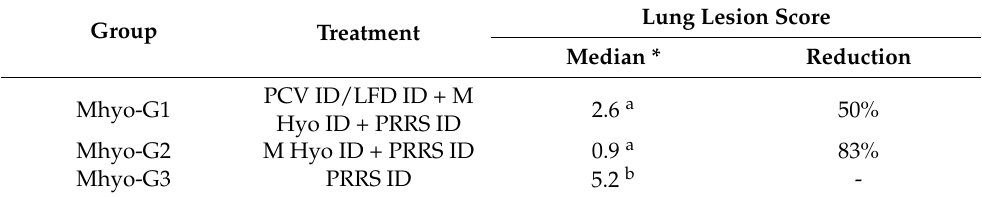
Table 2. Median lung lesion scores per group and reductions in the median compared to control group